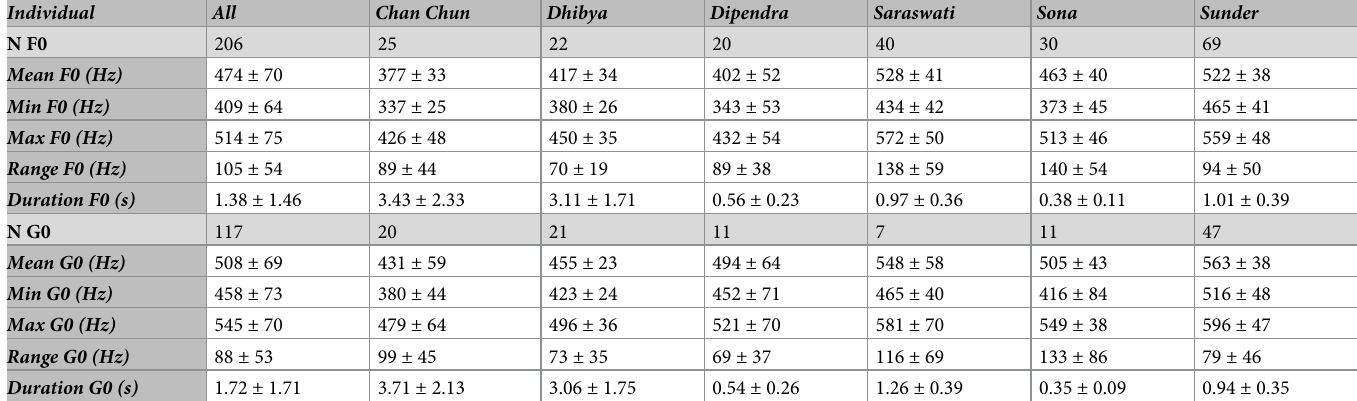
Table 4. Acoustic parameters measured in female Asian elephant trumpet calls presented as mean ± SD.